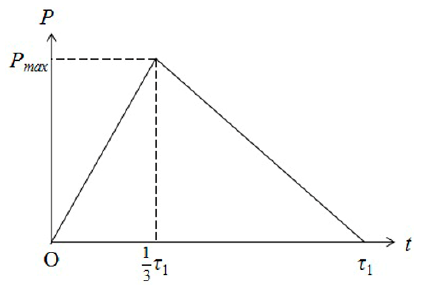
Figure 4. Schematic of laser-induced shock wave pressure vs. time.